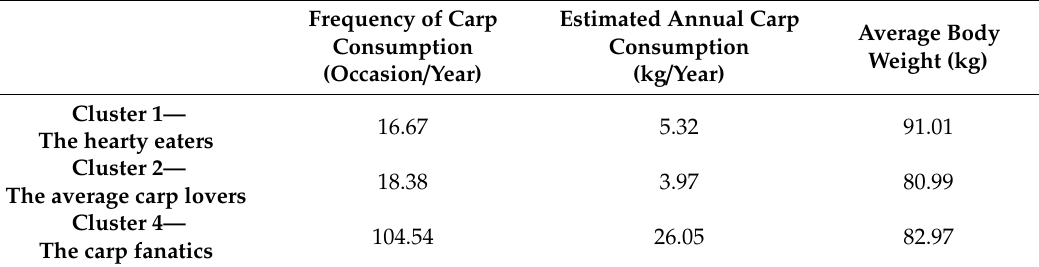
Table 3. Characteristics of the concerned clusters.